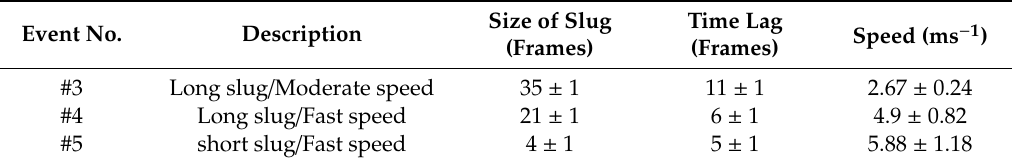
Table 2. Summary of the slug characteristics extracted from cross-correlation in terms of length and speed. Uncertainties are also mentioned.